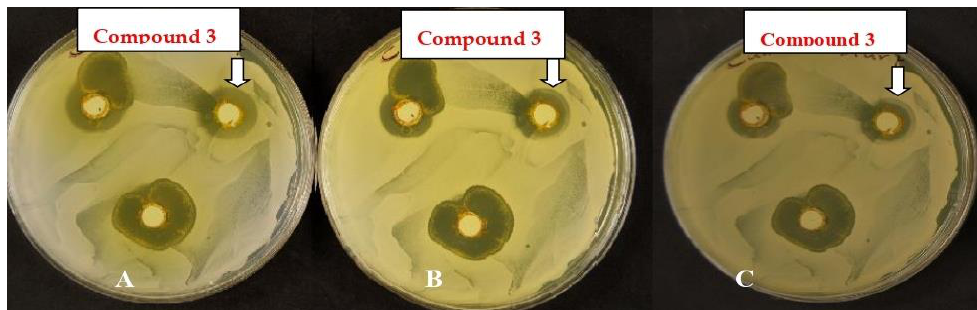
Figure 11. Candida albicans treated with 10mg ml − 1 of compound 3 after one day ( A ), three days ( B ) and six days ( C ) of incubation. It is worth noting that Figure 10 shows the cytolyticeffects of dyes number 5, 7 and 9a on Candida albican where after one, three and six days of incubation, the inhibition zone did not change (Figure 12).